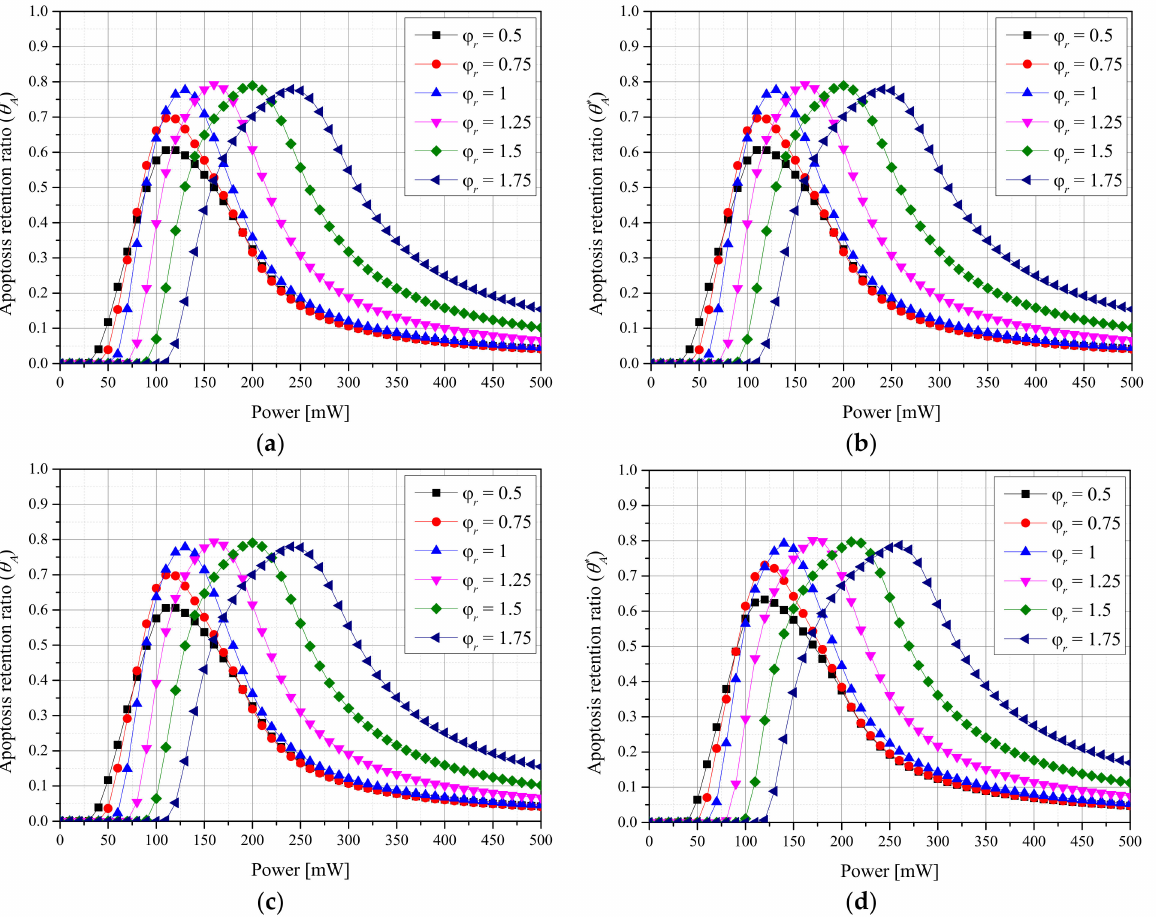
Figure 3. ( a ) f v = 10 − 3 . ( b ) f v = 10 − 4 . ( c ) f v = 10 − 5 . ( d ) f v = 10 − 6 . Apoptosis retention ratio ( θ ∗ different radius ratios ( ϕ r ) (top-hat